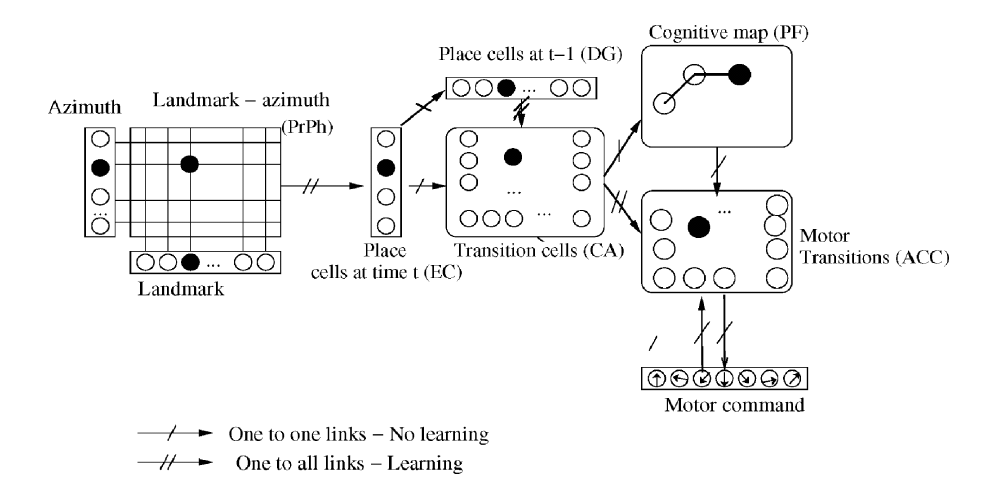
Figure 3. Sketch of the model . From left to the right: merging landmarks (Pr, perirhinal cortex) and their azimuth (Ph, parahippocampal cortex) in a matrix of neurons called product space (PS or PrPh)(maybe localized in the perirhinal and/or parahippocampal cortex), then learning of the corresponding set of active neurons on a place cell (ECs). Two successive place cells define a transition cell (CA). Place cell at time t − 1 is in DG. Transitions are used to build the cognitive map (PF) and are also linked with the integrated movement performed